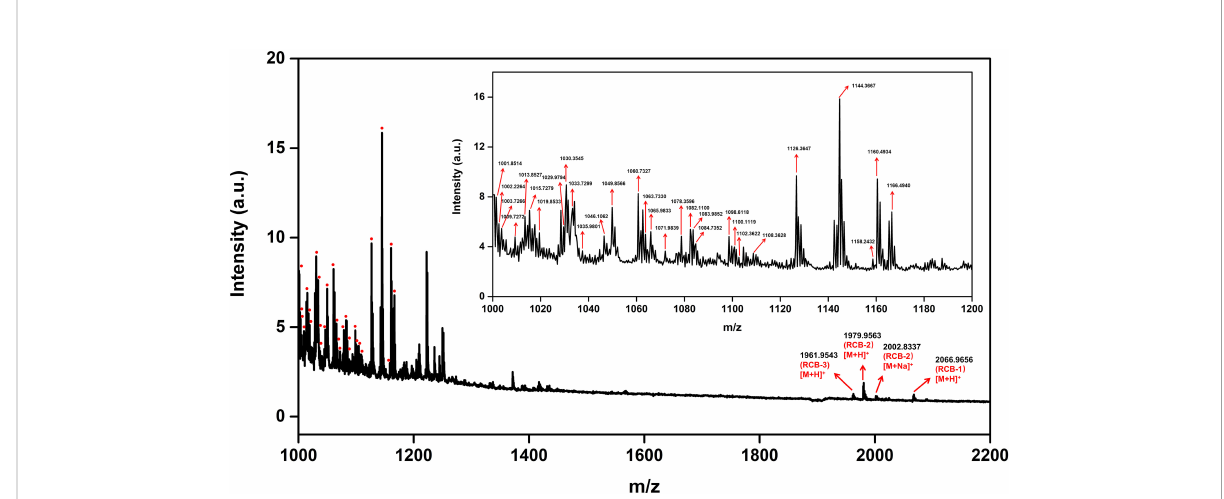
FIGURE 3 Average mass spectrum of tissue sections “ no wash. ” The red dot indicates the annotated